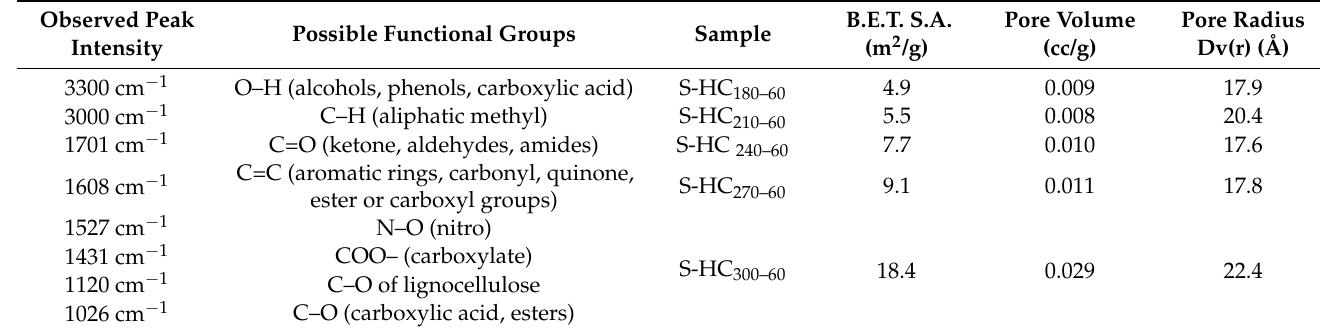
Table 2. FTIR assignments and structural properties of the hydrochar samples at different reaction temperatures and a fixed reaction time of 60 min.